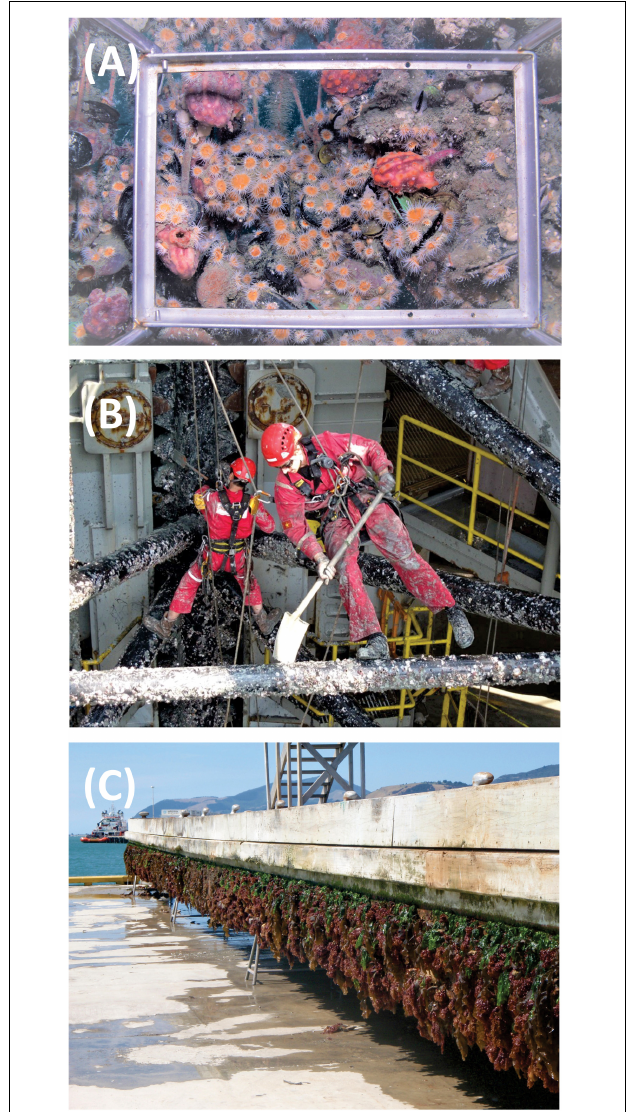
FIGURE 1 | Biofouling occlusion of a salmon farm predator net (A) , removal of biofouling from a jack-up drilling rig while it is being transported on-board a heavy-lift vessel (B) , and a superyacht marina berth removed from the water to undergo maintenance (C) . Image credits: Cawthron